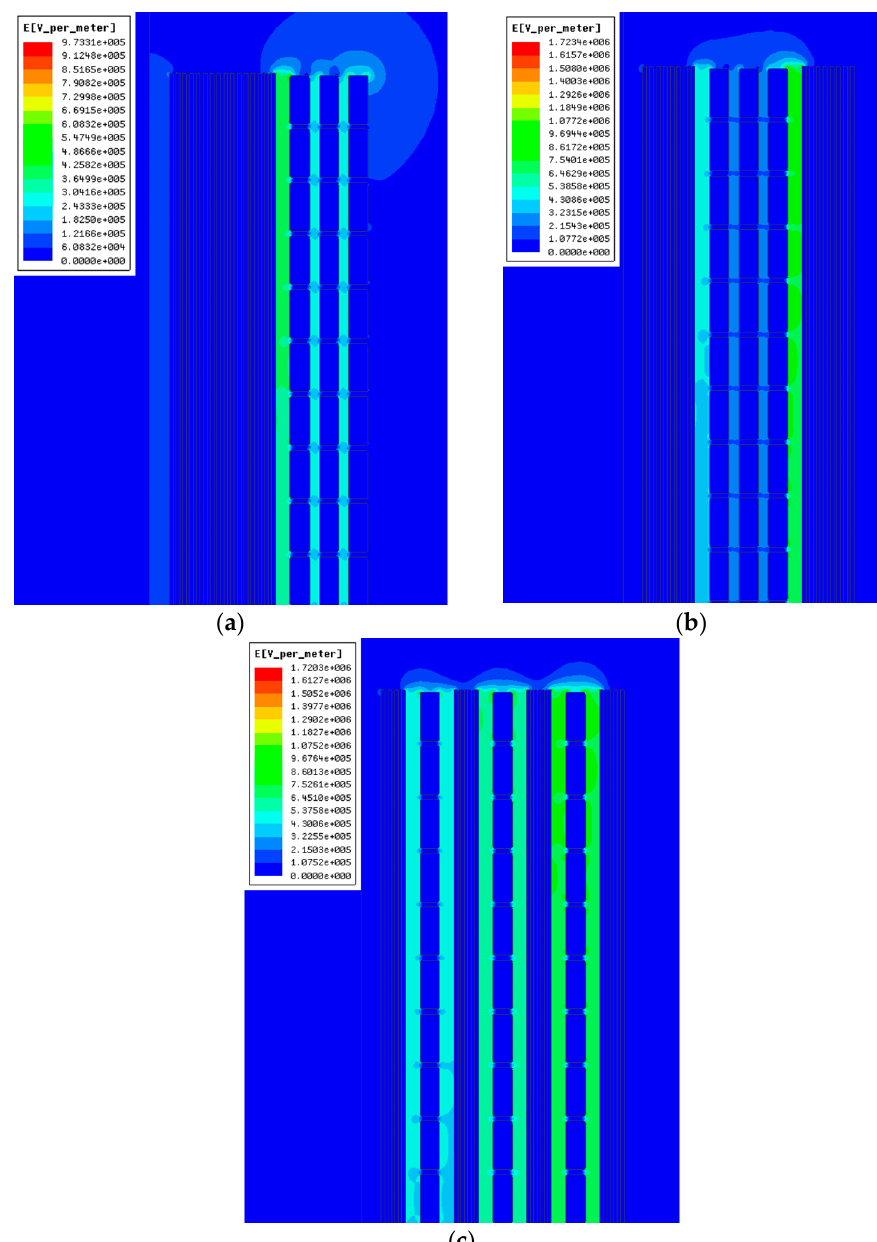
Figure 9. Electric field distribution for three windings: ( a ) Non-interleaved winding N-1; ( b ) Interleaved winding I-1; ( c ) Interleaved winding I-2.